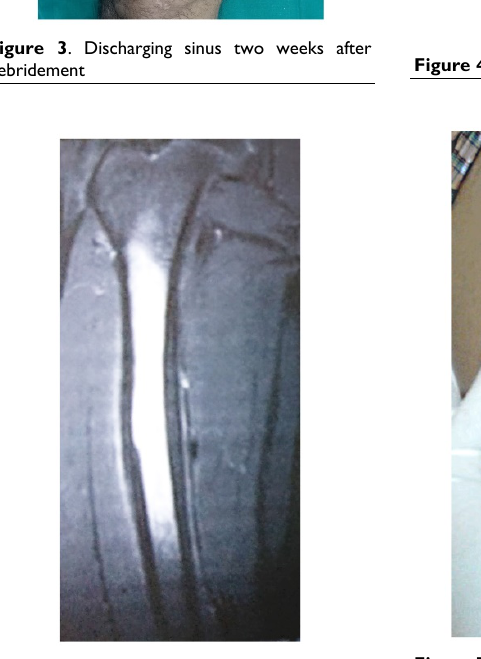
Figure 7. Surgical site discharge